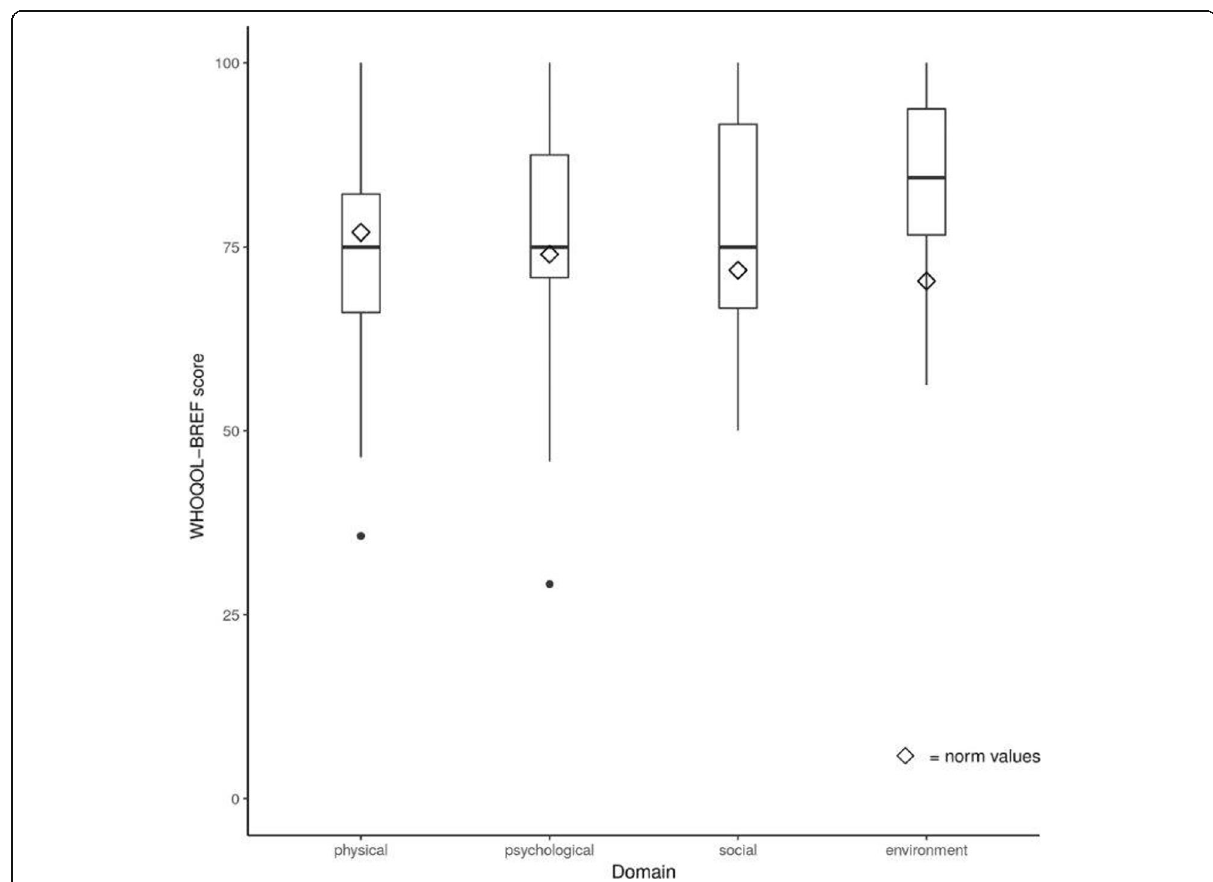
Fig. 1 Distribution of the WHOQOL-BREF subscales at baseline of study participants compared to normative